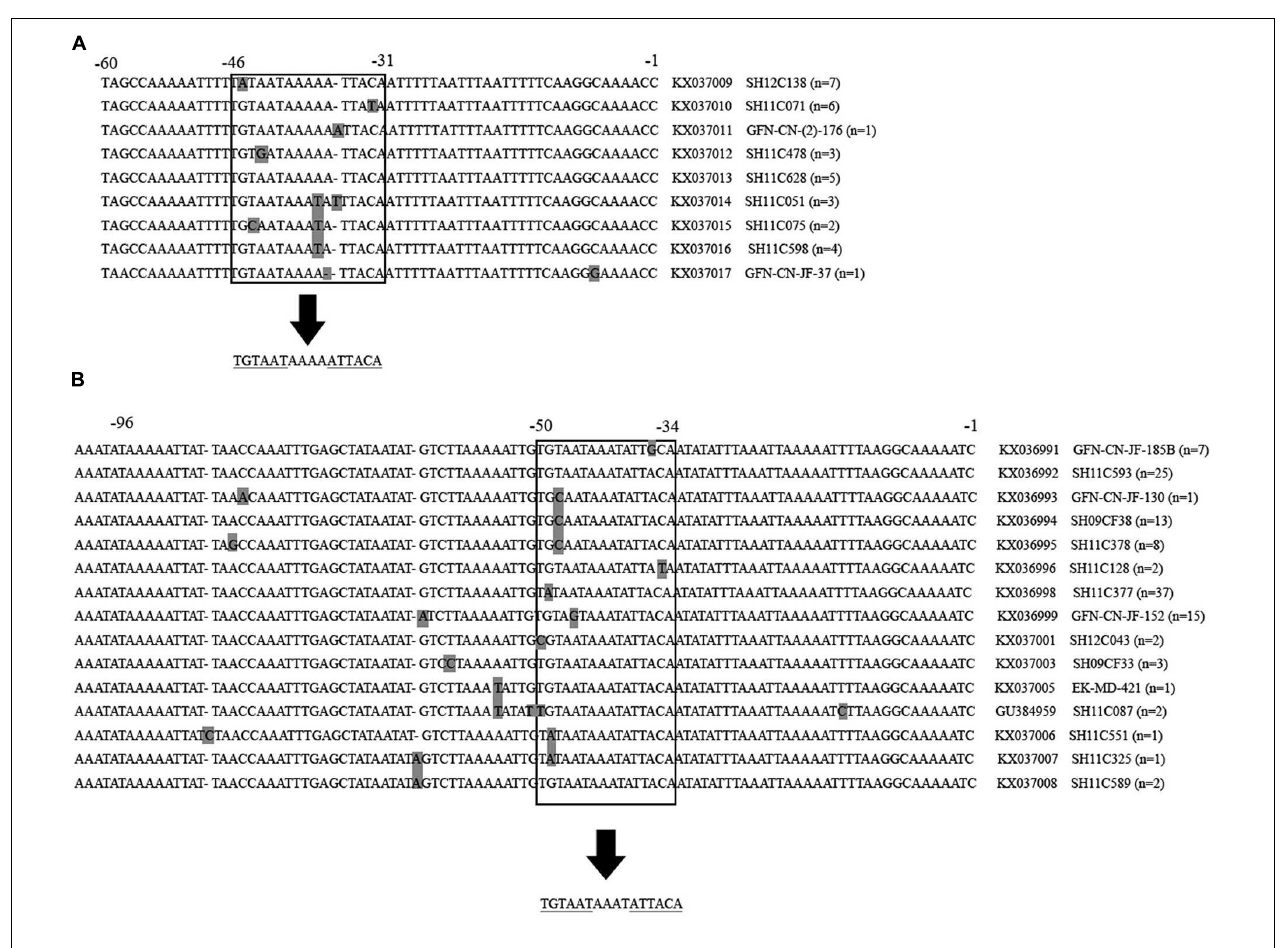
FIGURE 3 | Partial multiple alignment of the intergenic regions between cmeR and cmeABC identified in multidrug-resistant Campylobacter jejuni and Campylobacter coli isolates. Polymorphisms are shown in gray squares. The inverted repeat regions are shown inside the open squares, and under the arrows the consensus sequence is shown. Repeated sequences are underlined. Positions are indicated on the top of the alignment. Partial sequences are shown. (A) Alignment of the 94 bp intergenic region of Campylobacter jejuni isolates. A total of 9 novel identified sequences are presented, followed by the accession number, a representative isolates of each sequence type and the number of isolates belonging to this sequence type. (B) Alignment of the 107 bp intergenic region of Campylobacter coli isolates. A total of 15 sequences were identified, including 14 novel ones, followed by the accession number, a representative isolates of each sequence type and the number of isolates belonging to this sequence